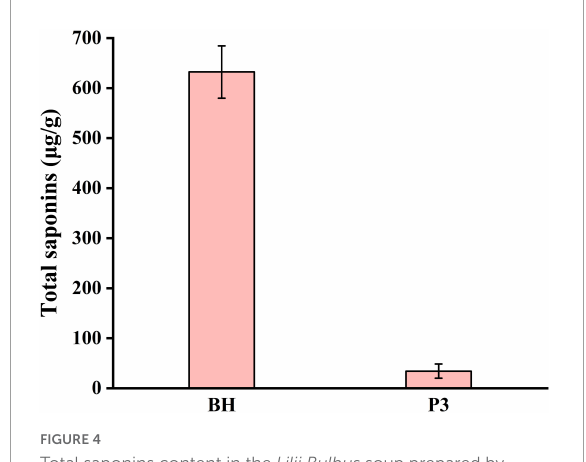
FIGURE4 Total saponins content in the Lilii Bulbus soup prepared by process 3. BH: Lilii Bulbus , P3, Process 3.